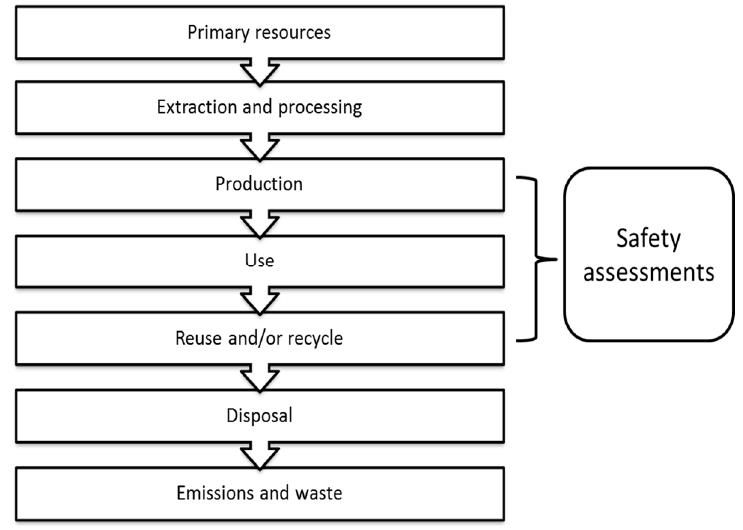
Figure 9. Life cycle of the packaging [67].